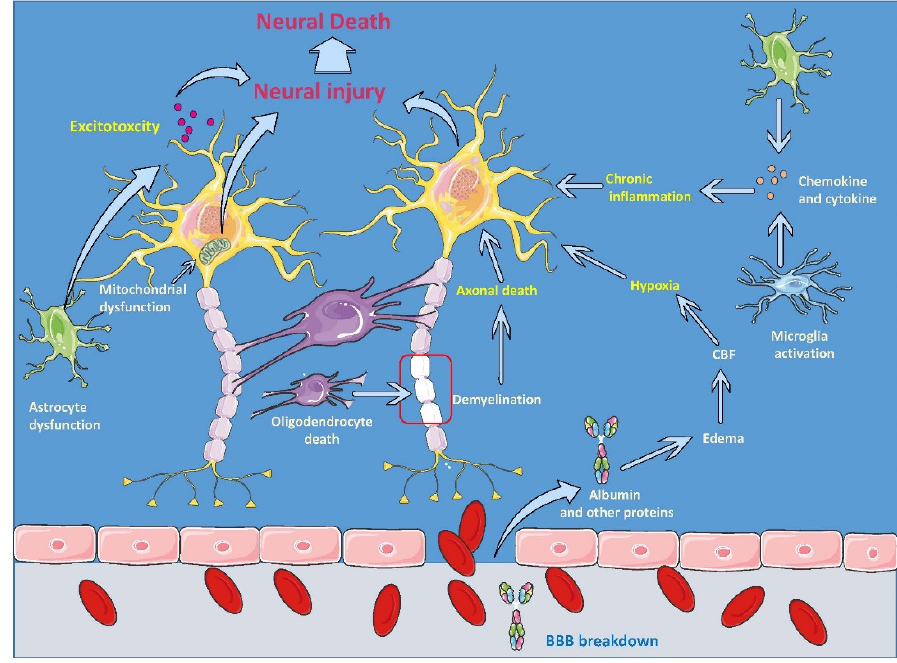
Figure 1. Traumatic brain injury (TBI) pathobiology. The primary insult of TBI results in blood-brain barrier (BBB) breakdown and necrotic death of neurons. Following the BBB breakdown, perfusion, and increased edema, leading to increased hypoxia results in neural injury and death. Aberrant neurotransmitter release from the injured neurons leads to excitotoxic cell injury and death. Astroglial and microglial cell activation releases numerous cytokines and chemokines, both leading to chronic inflammation. The further cellular injury occurs due to oligodendrocyte death and axonal death. Abbreviations: BBB, blood-brain barrier; CBF, cerebral blood flow; TBI, traumatic brain injury.